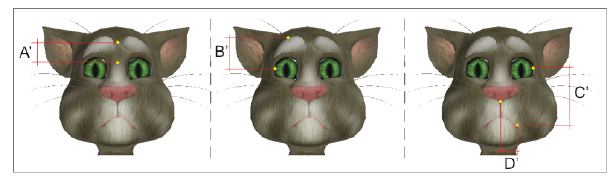
Figure 18. Measures of the new model without expressions.